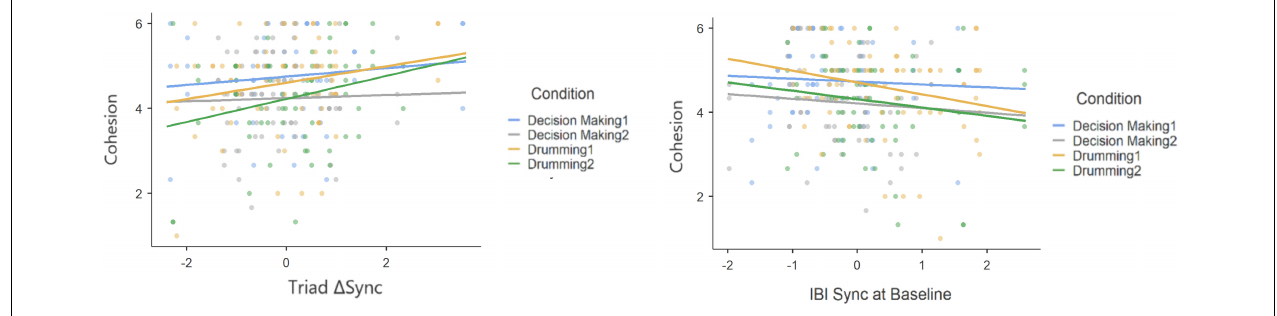
FIGURE 6 | Scatter plots and slopes for the IBI data during task minus baseline (triadic (cid:49) Sync) and the baseline data (IBI Sync at Baseline).